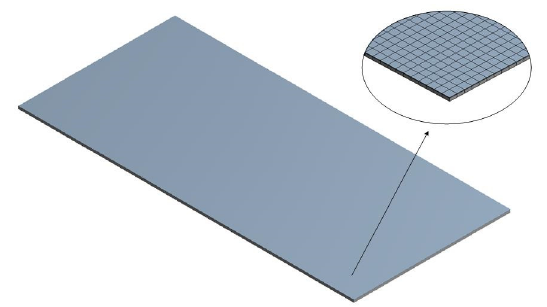
Figure 15. Dimensions of the coating and substrate . Figure 15. Geometric model consisted of the powder coating and metal Table 6. Dimensions of the coating and substrate.